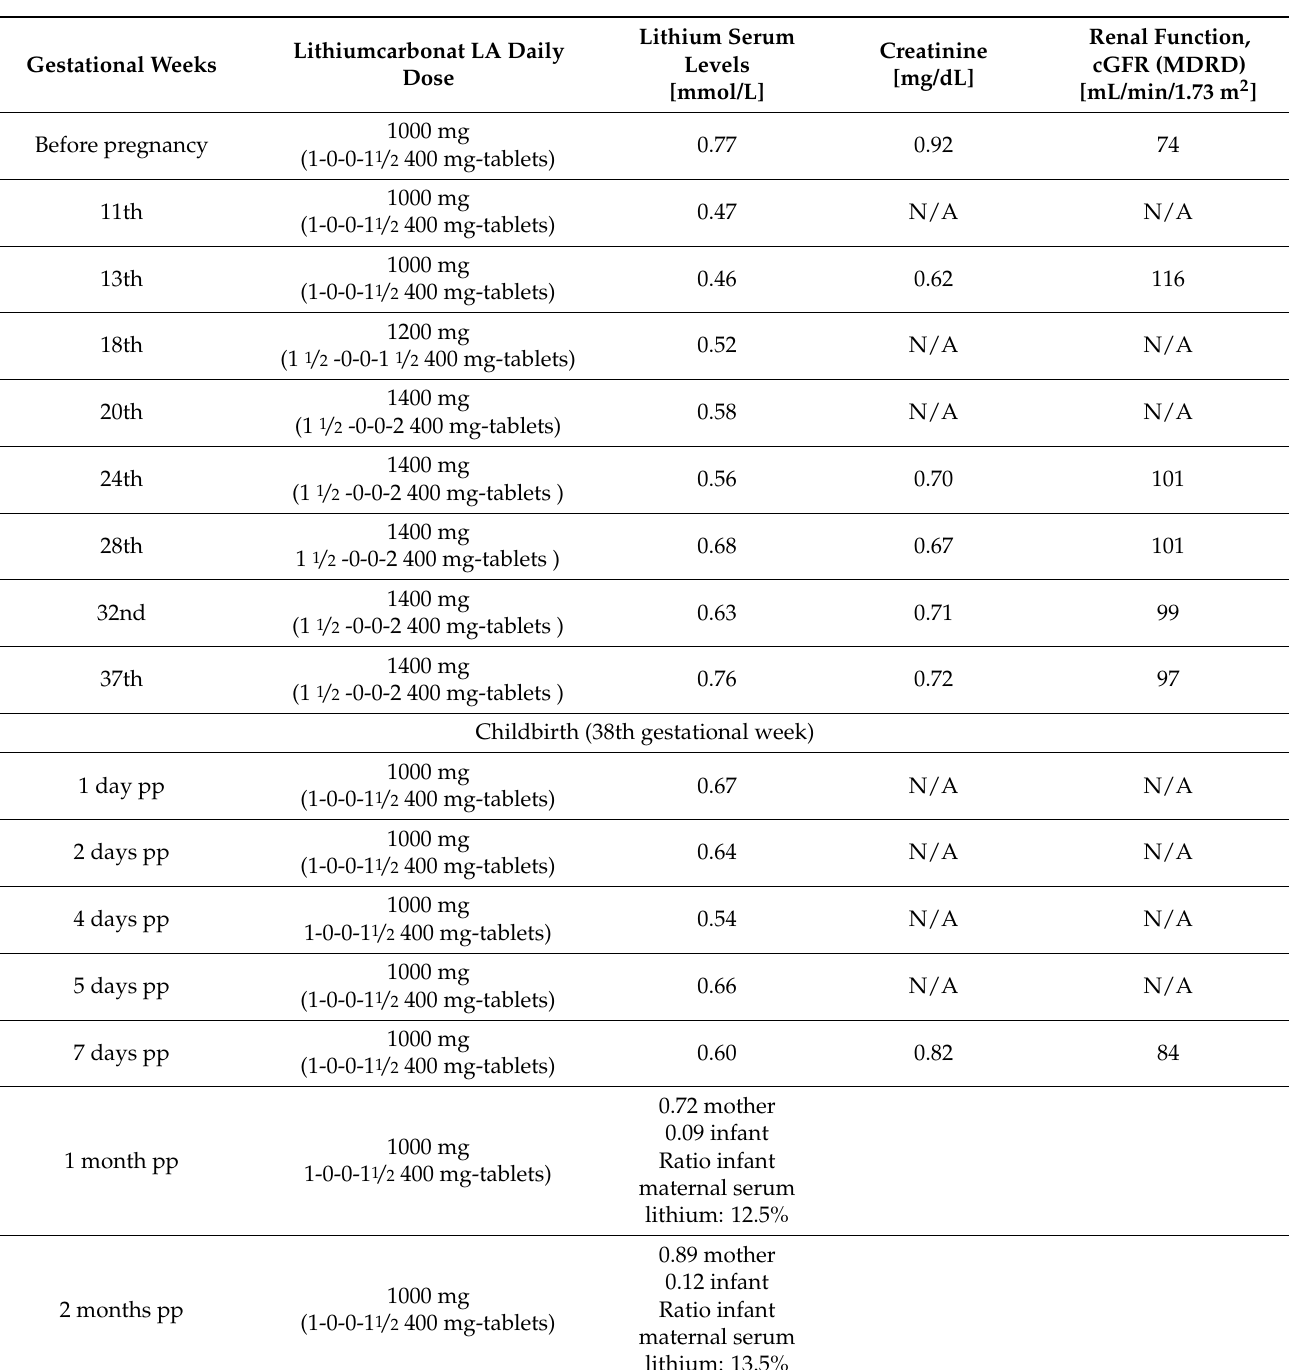
Table 1. Clinical data case